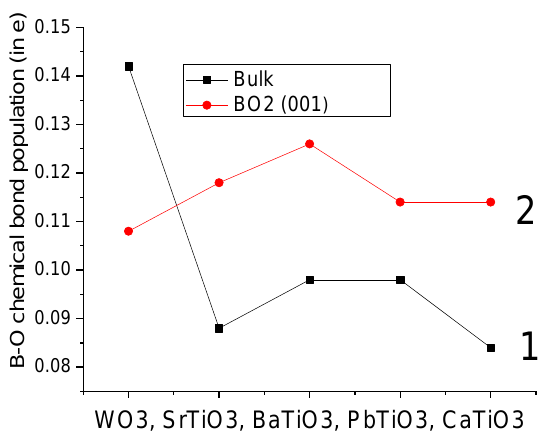
Figure 4. Our ab initio-calculated bulk (1) as well as BO 2 -terminated (001) surface (2). B–O chemical bond populations (in e ) for WO 3 , SrTiO 3 , BaTiO 3 , PbTiO 3 and CaTiO 3. As can be seen in Table 9 and Figure 5, our B3LYP- or B3PW-calculated WO 3 , SrTiO 3 , BaTiO 3 , PbTiO 3 and CaTiO 3 bulk band gaps at the Γ – Γ point were always reduced near the WO 2- or TiO 2 -terminated WO 3 , SrTiO 3 , BaTiO 3 , PbTiO 3 and CaTiO 3 (001) surfaces. The B3PW-calculated SrTiO 3 bulk band gap at Γ – Γ point near the TiO 2 -terminated SrTiO 3 (001) surface at Γ – Γ point was reduced only by 0.01 eV. At the same time, our B3LYP-calculated WO 3 bulk band gap (4.95 eV) at the Γ – Γ point near the WO 2 -terminated WO 3 (001) surface was reduced by 3.79 eV to 1.16 eV (Table 9 and Figure 5). Table 9. B3LYP- or B3PW-calculated Γ – Γ band gaps for WO 3 , SrTiO 3 , BaTiO 3 , PbTiO 3 and CaTiO 3 bulk as well as their WO 2 or TiO 2 -terminated (001) surfaces.